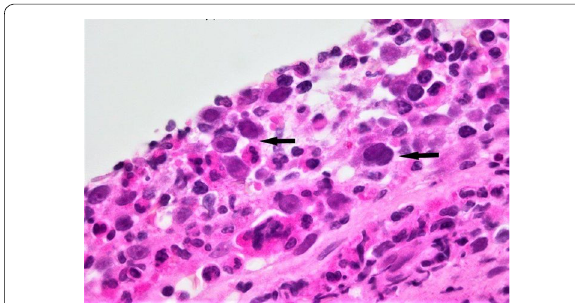
Fig. 2 H&E: 1000 magnification showing cytomegalovirus (CMV) × infected cells (black arrows). CMV-infected cells are enlarged, show eosinophilic intranuclear inclusions with halos (Cowdry type B inclusions) as well as ill-defined amphophilic intracytoplasmic inclusions